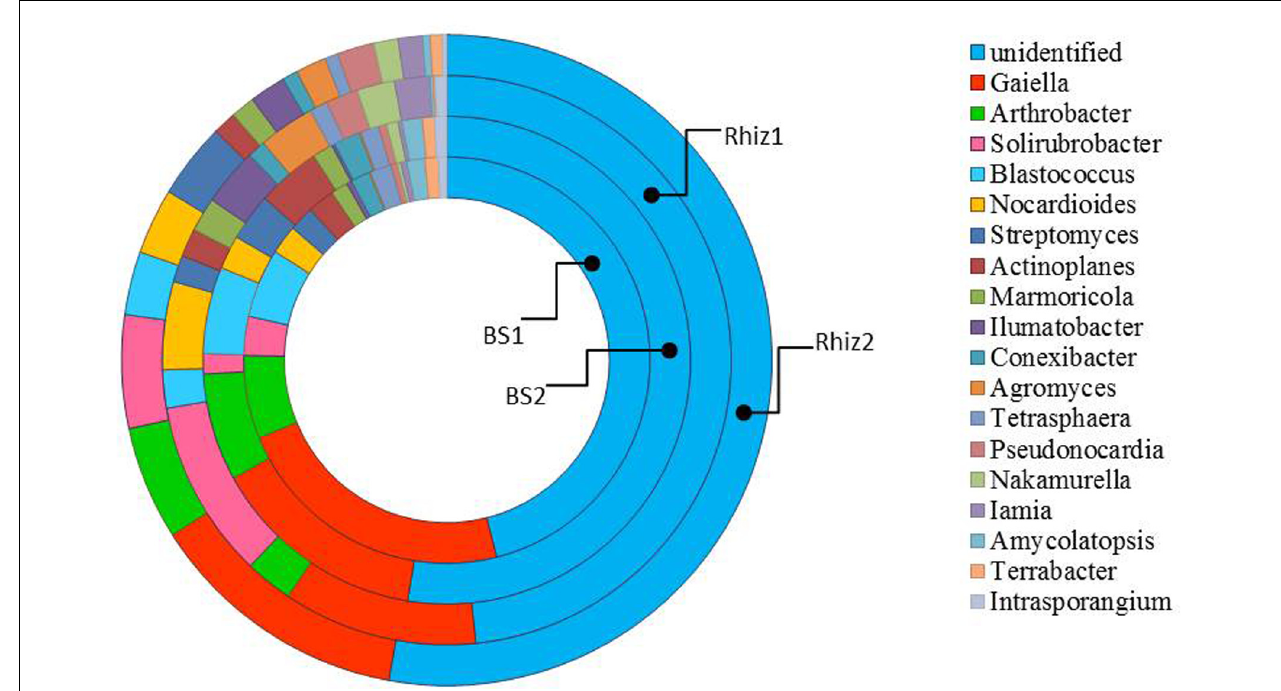
FIGURE 5 | Distribution of the genera belonging to the class Actinobacteria in bulk soil and rhizosphere of V. vinifera cv. Pinot Noir during the two sampling dates (flowering and early fruiting). From the center to the edge BS1, BS2, Rhiz1,